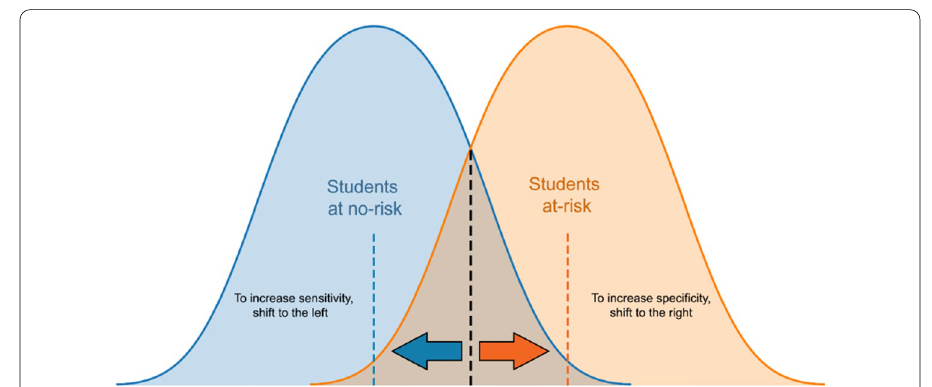
Fig. 3 Sensitivity specificity trade-off. It is adapted from Steward